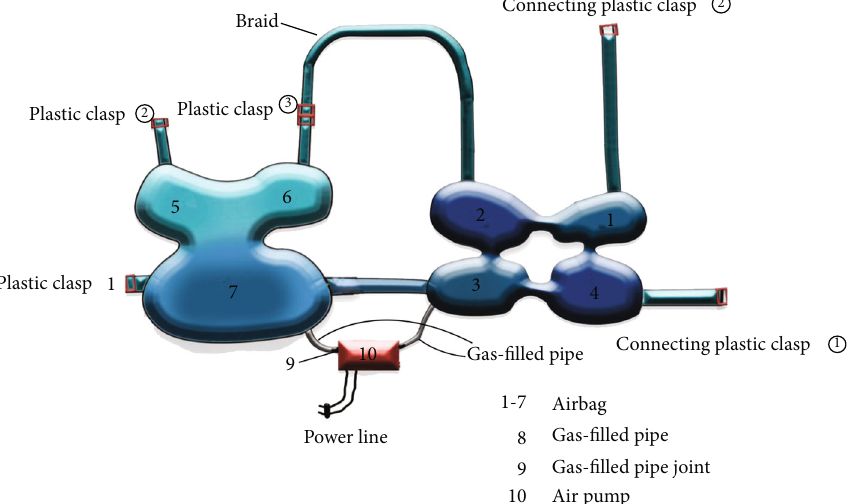
Figure 5: Schematic diagram of airbag design.